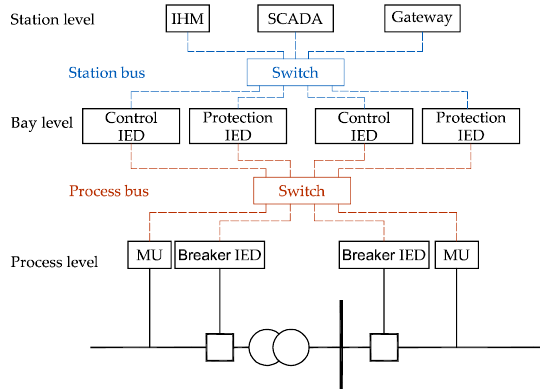
Figure 5. Substation architecture based on IEC 61850.